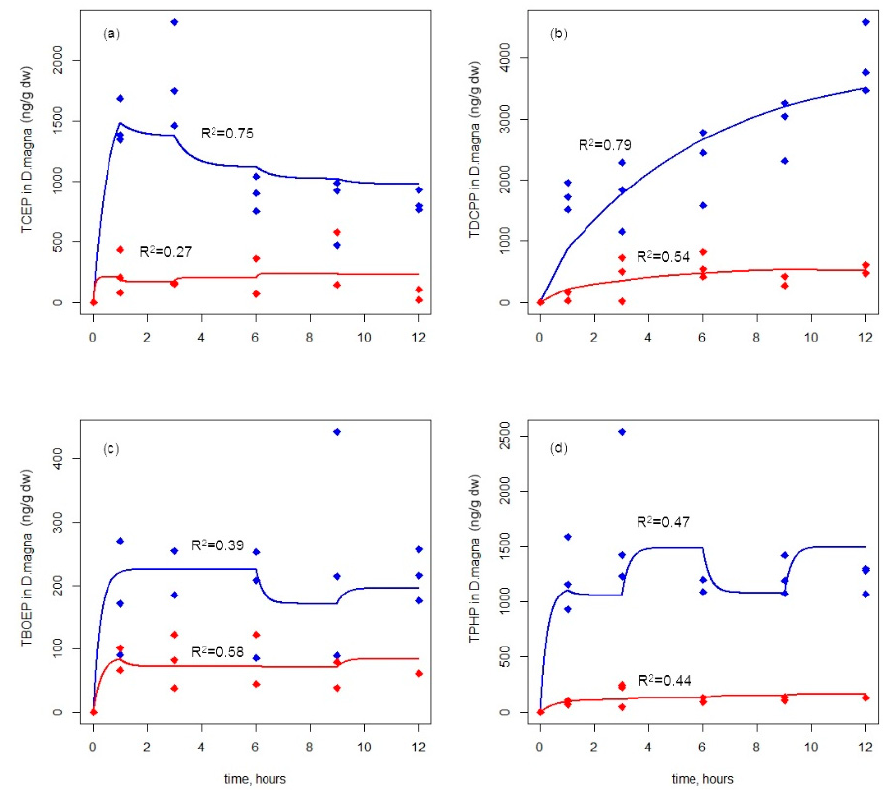
Figure 2. Uptake kinetics of four OPEs (( a ) TCEP, ( b ) TDCPP, ( c ) TBOEP, ( d ) TPHP) in D. magna via dietary exposure. Blue lines (toxicokinetics model simulations) and points (experimental data) represent the high-concentration group (100 µ g/L), and red lines (toxicokinetics model simulations) and points (experimental data) represent the low-concentration group (20 µ g/L).